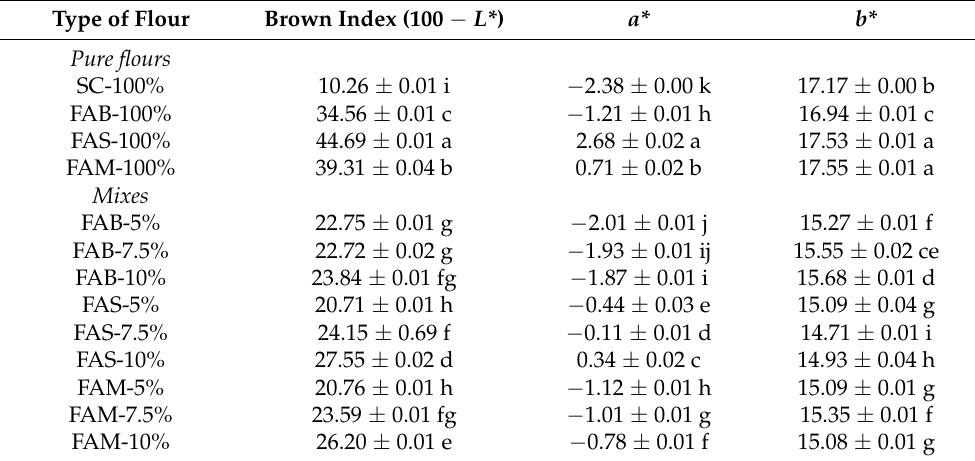
Figure 1. Flour prepared from artichoke waste. From left to right, flour of: artichoke bracts; artichoke stems; mix of artichoke bracts and stems 1:1. Table 2. Color parameters of re-milled semolina (control), of flours of artichoke stems and bracts, and of mixes prepared with re-milled semolina and artichoke flours at increasing levels of replacement (5, 7.5, 10%) of the